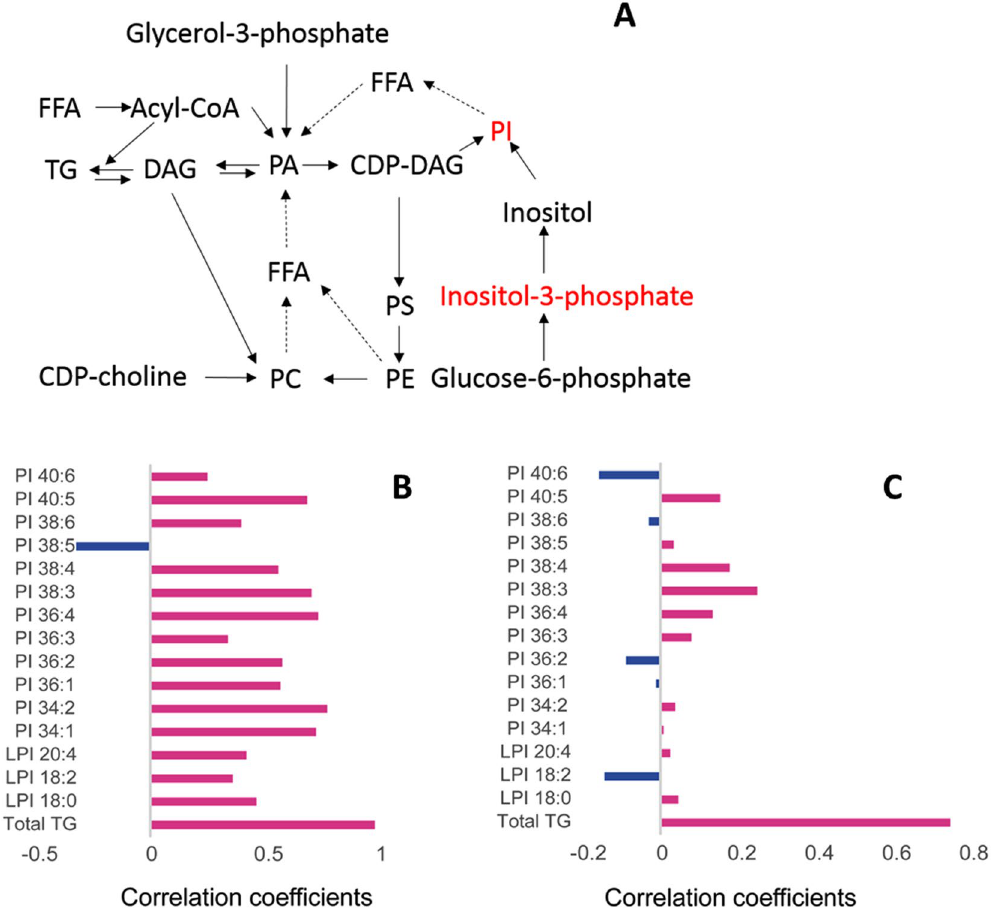
Figure 5. Major pathways of phospholipid and neutral lipid synthesis. ( A ) Dashed lines show fatty acid rearrangement through the remodeling process. Correlation analysis of very low-density lipoprotein, phosphatidylinositol, lysophosphatidylinositol, and total triglycerides in ( B ) recovered SARS and ( C ) healthy volunteers